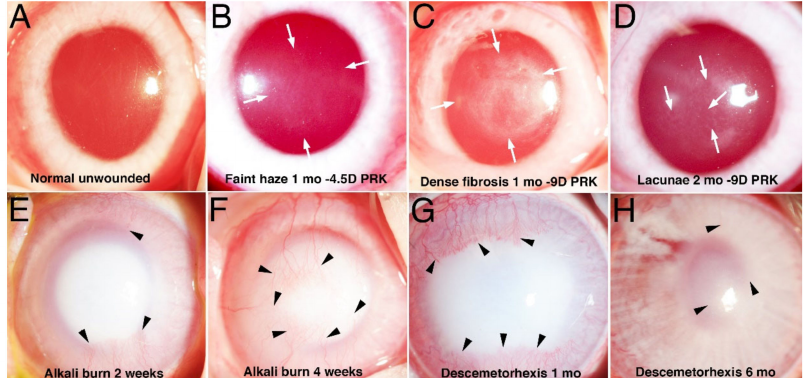
Figure 1. Slit lamp photographs of haze and scarring fibrosis in rabbit corneas. ( A ) Normal un- wounded transparent cornea. ( B ) One month after − 4.5D PRK a cornea has faint opacity (haze) within arrows [5]. ( C ) One month after − 9D PRK a cornea has dense scarring fibrosis within arrows [5]. ( D ) At 2 mo. after − 9D PRK areas of clearing (lacunae, arrows) are developing within scarring fibrosis [5]. ( E ) Dense scarring fibrosis 2 weeks after 5 mm surface alkali burn with 1 N NaOH. Stromal neovascularization (arrowheads) begins to develop. ( F ) Scarring fibrosis has progressed at 4 weeks after alkali burn. Stromal neovascularization (arrowheads) has progressed. ( G ) Dense scarring fibrosis 1 mo. after 8mm Descemetorhexis. Stromal neovascularization (arrowheads) has developed [7]. ( H ) Scarring fibrosis has diminished by 6 mo. after Descemetorhexis with iris details now visible. Most of the opacity that remains is associated with the corneal neovascularization (arrowheads) [7]. Mag. 20 × .